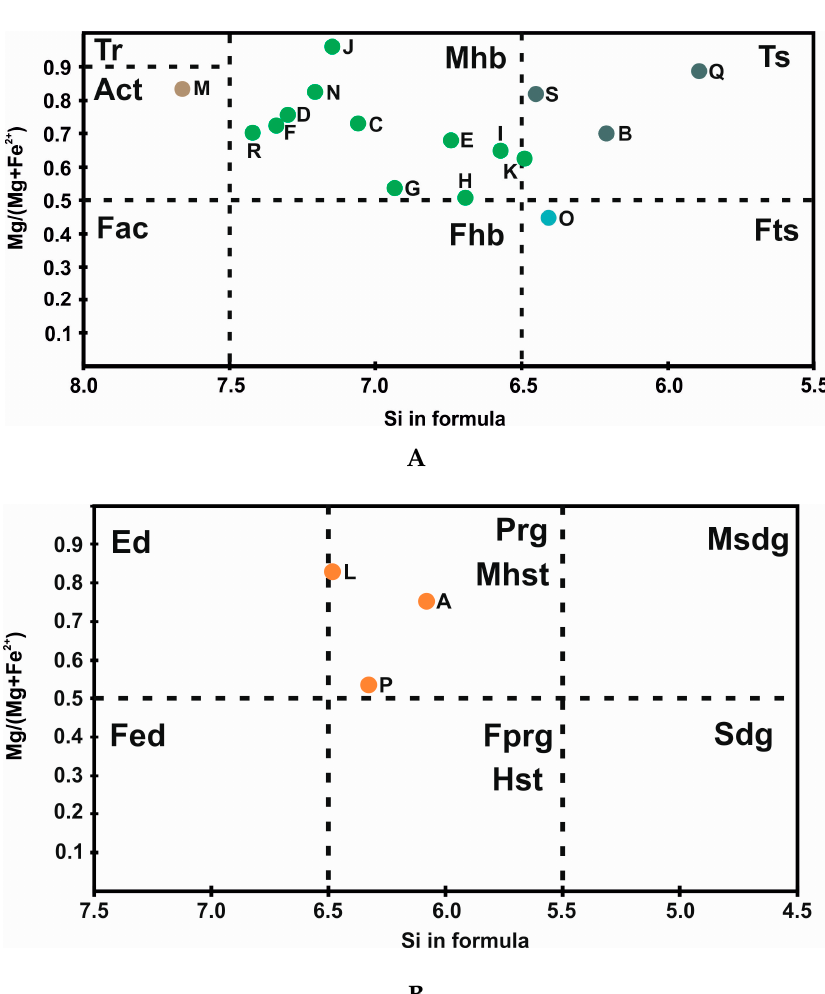
Figure 14. A (upper diagram) shows the presence of magnesio-horneblend (Mhb), tschermakite (Ts), ferro-tschermakite (Fts) and actinolite (Act). In this diagram tremolite (Tr), ferro-actinolite (Fac), ferro- hornblend (Fhb) were not found. B (lower diagram) shows the presence of pargasite (Prg). In this diagram edenite (Ed), magnesio-hastingsite (Mhst), hastingsite (Hst) ferro-edenite (Fed), magnesio- sadanagaite (Msdg), and sadanagaite (Sdg) were not found. Mineral grains D–N are from sample P6; A–C are from sample P3; P–S are from sample P20; O is from P17. The location of the samples can be seen on Figure 11. These diagrams project chemical analysis data of calcic amphiboles from samples collected from the Porto canyon